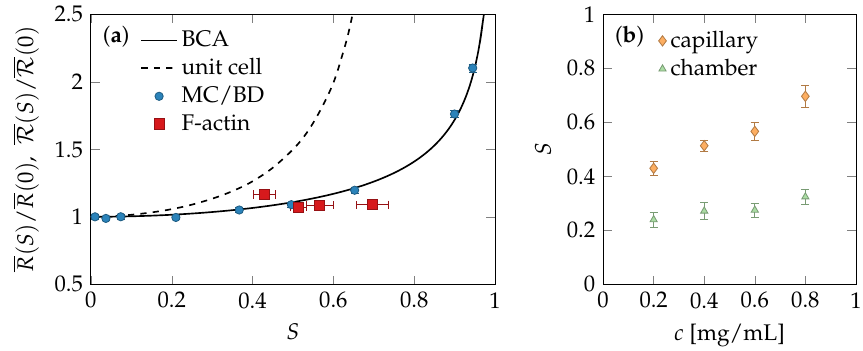
Figure 3. Nematic alignment and tube deformation. ( a ) Dependence of the mean tube radius R on the nematic order as predicted by the binary-collision approximation (BCA) calculation, Equation (2), and the unit-cell model. The four experimental data points correspond to four different F-actin concentrations c . Our Monte-Carlo/Brownian-Dynamics (MC/BD) simulations of pre-aligned polymer solutions and F-actin experiments show no sign of the strong strain-induced tube dilation predicted by the unit-cell model but agree with the BCA predictions for moderately pre-aligned tubes, corresponding to shear alignment by a strain of about γ = 1.5 . . . 2.5. We interpret this as an indication that the average tube deformations had mostly relaxed between the cessation of shear and the start of the measurements, while the inflicted shear alignment was largely conserved. Note that the statistical errors of the tube size is very small ( 1%) for both the experiments and the simulations; ( b ) Polymer ≈ solutions were prepared in two different sample geometries for each c , a narrow capillary and a wider micro chamber, to get strongly sheared networks and weakly sheared reference samples, yielding 0 ) , respectively. Their ratio is shown in panel ( a ) against the values for S values for R ( S ) and R ( S ≈ in the capillary.